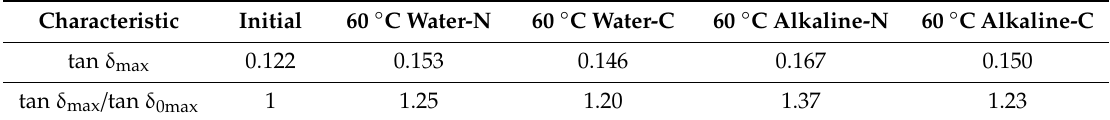
Table 3. Tan δ variation of specimens immersed for three